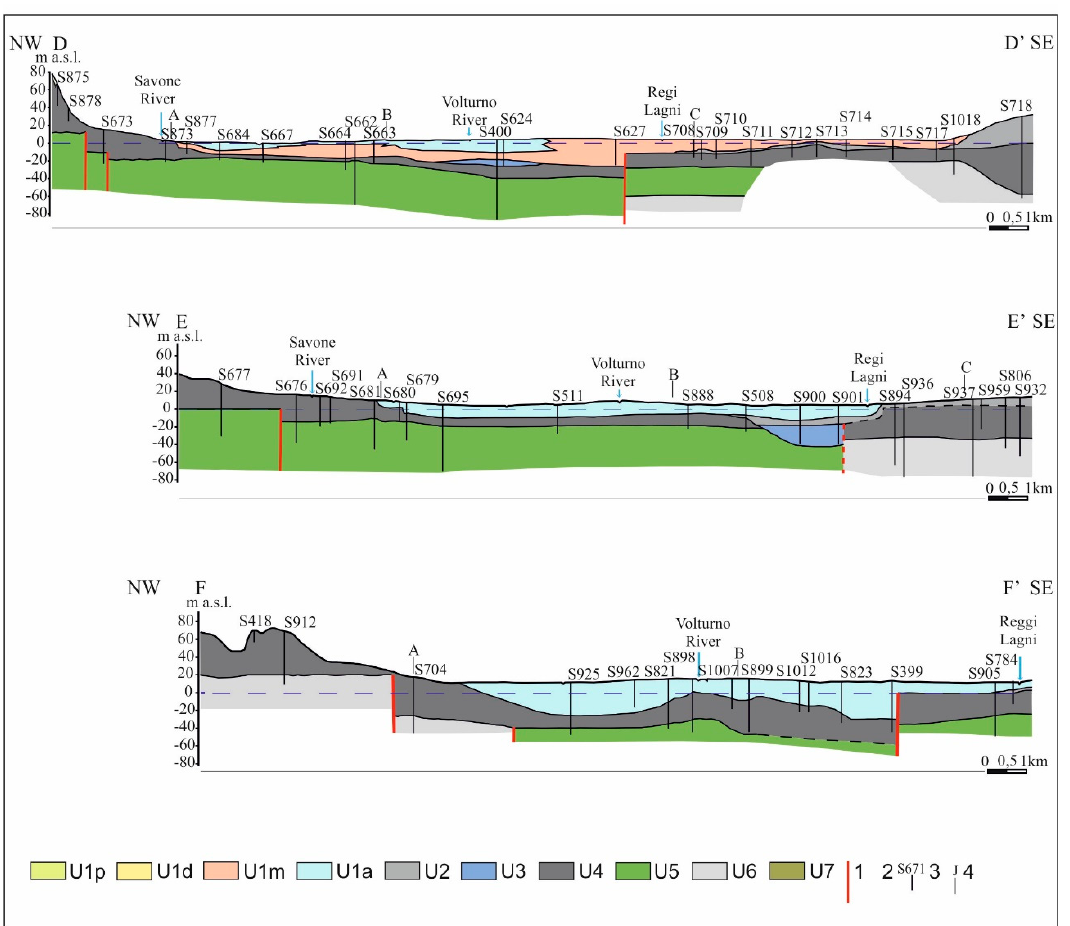
Figure 4. D–D’, E–E’, and F–F’ geological cross sections. U1p: pro-delta deposits; U1d: beach-dune ridge deposits; U1m: lagoonal-swamp deposits; U1a alluvial deposits; U2: pyroclastic flow and fall deposits (12–23 ky); U3: Pleistocene alluvial deposits (23?–37 ky); U4: Campanian Ignimbrite deposits (CI, about 40 ky); U5: coastal-marine and transitional deposits with alluvial deposits (40?–50 ky); U6: pre-Campanian Ignimbrite volcaniclastic deposits (50–105 ky); U7: coastal-marine and transitional deposits (105–130 ky); 1: fault; 2: uncertain fault; 3: borehole; 4: interception with cross sections.